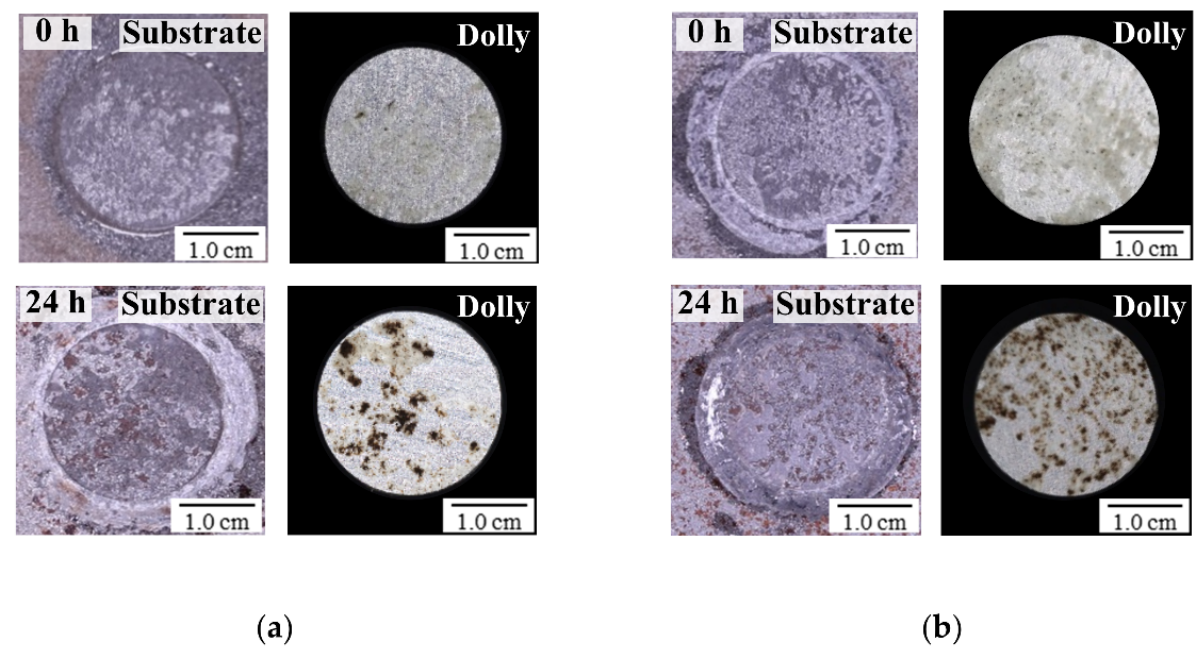
Figure 17. Fracture surface conditions after the adhesion tests on the unpainted surfaces after 0 and 24 h exposure: ( a ) CST, ( b ) CAL.